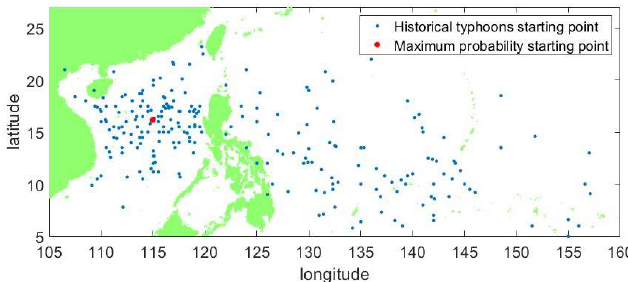
Figure 2. Historical typhoon starting points and the maximum probability starting point.